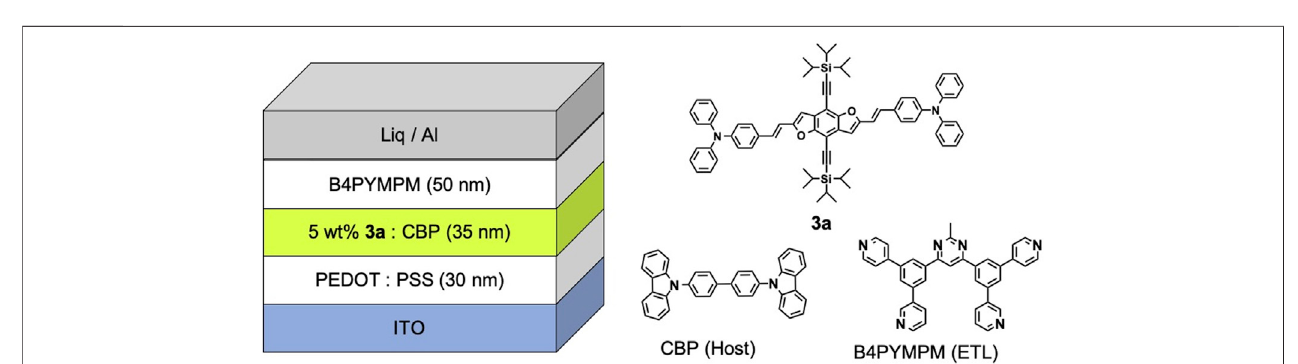
FIGURE 1 | The con fi guration of the OLED device and the chemical structures of 3a , CBP and B4PyMPM.